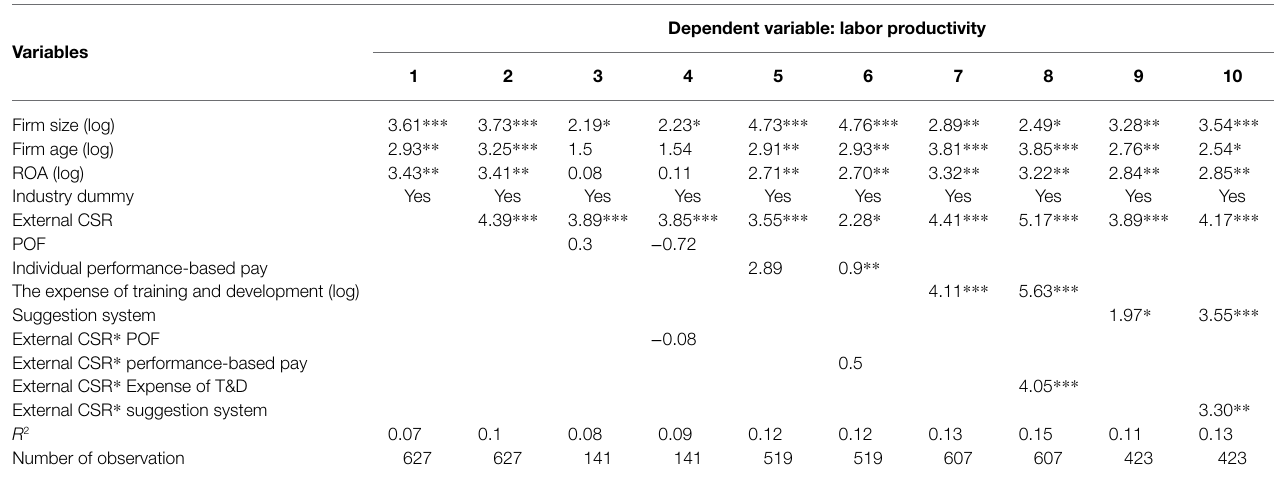
TABLE 3 | Results of regression analysis of the CSR, HR practices, and productivity.